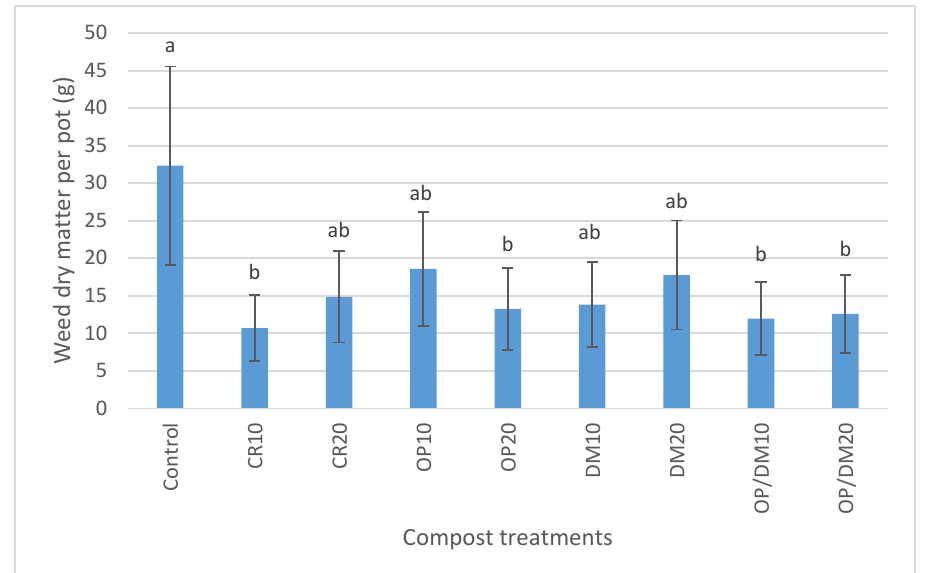
Figure 7. Total weed dry matter production as affected by different compost sources and rates. Error bars represent ± standard error ( P = 0.021, n = 6). Bars sharing the same letter are not statistically different according to Tukey’s HSD test (at P < 0.05).